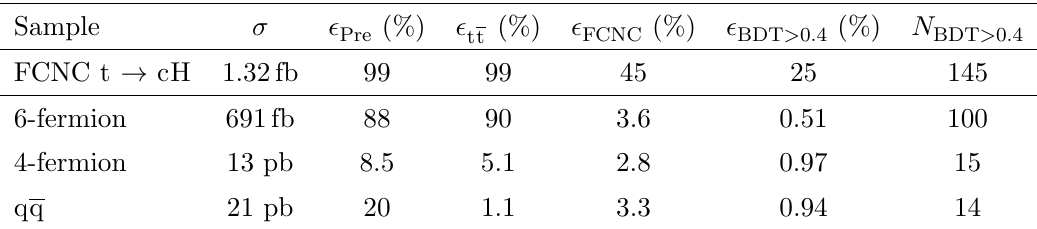
Table 15. Cross section values, selection e(cid:14)ciencies, and numbers of events expected for signal and background processes in the analysis searching for FCNC decay t ! cH at CLIC at 380 GeV. Selection e(cid:14)ciencies are quoted for pre-selection ( (cid:15) ) and classi(cid:12)cation ( (cid:15) ) of tt events, as well Pre tt as for selection of FCNC candidate events ( (cid:15) ) and selection of signal dominated sample with FCNC cut on BDT response ( (cid:15) ). Numbers of events correspond to a luminosity of 1.0 ab (cid:0) 1 with BDT > 0 : 4 equal amounts of -80% and +80% polarisation running, and BR(t ! cH) (cid:2) BR(H ! bb) = 10 (cid:0) 3 for signal